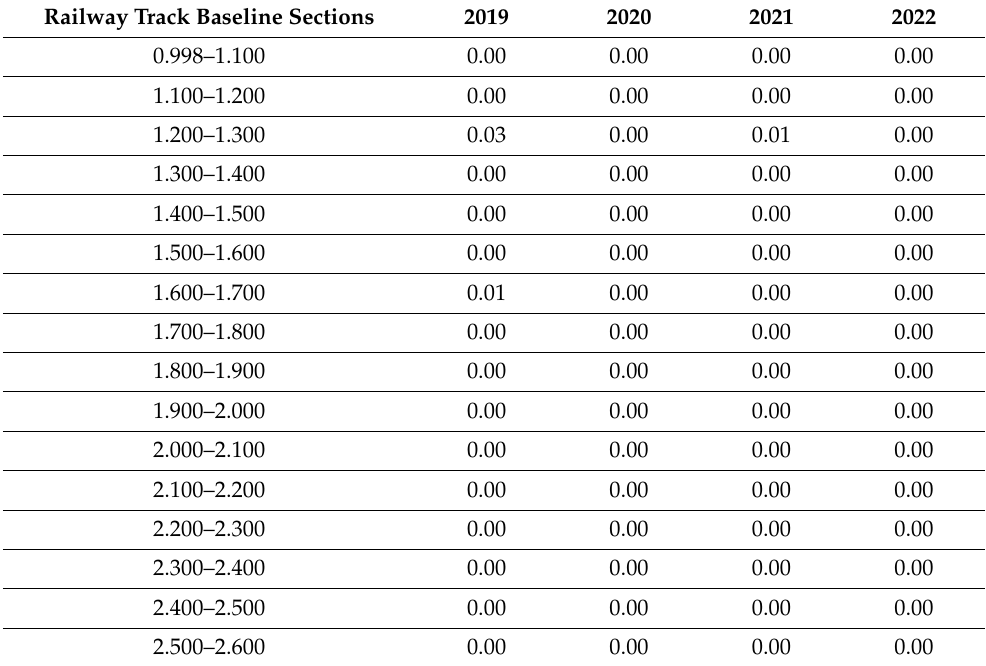
Table A6. Estimates of the railway track condition—relative D 5 , object Nos. R 143_1_1 and R 143_1_2. Railway Track Baseline